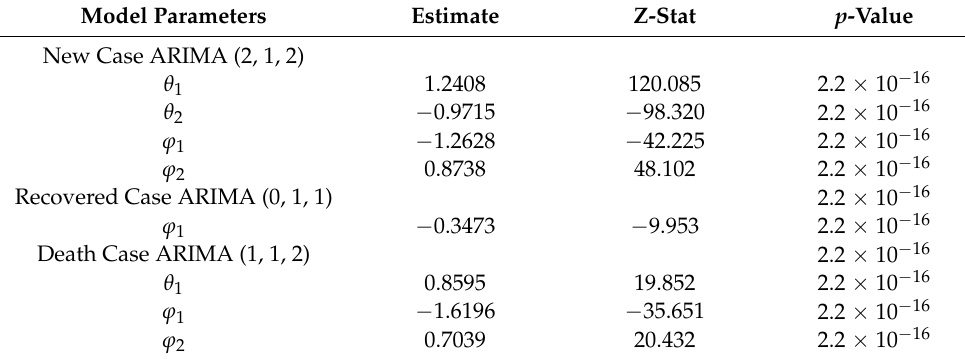
Table 3. Parameter estimates of ARIMA models and their p -values.